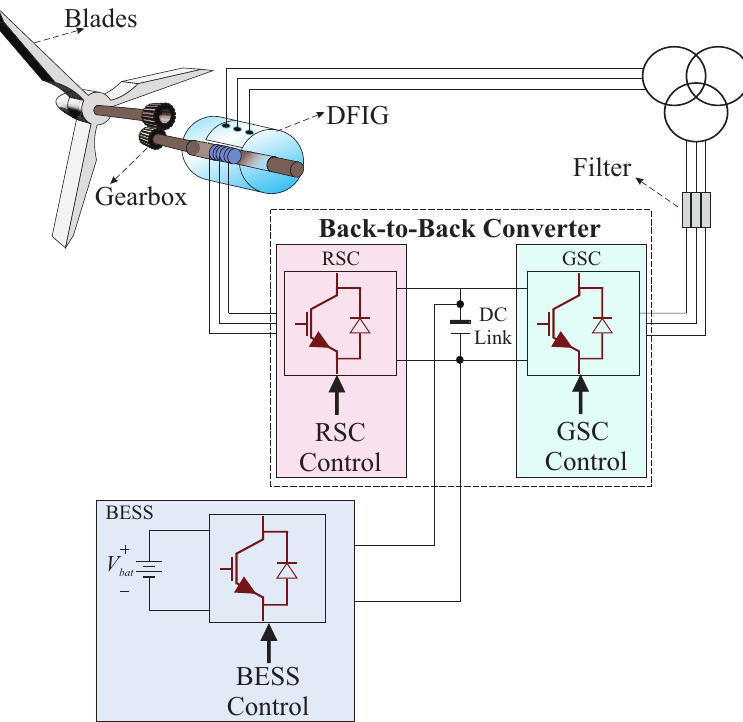
Figure 1. DFIG wind system plus